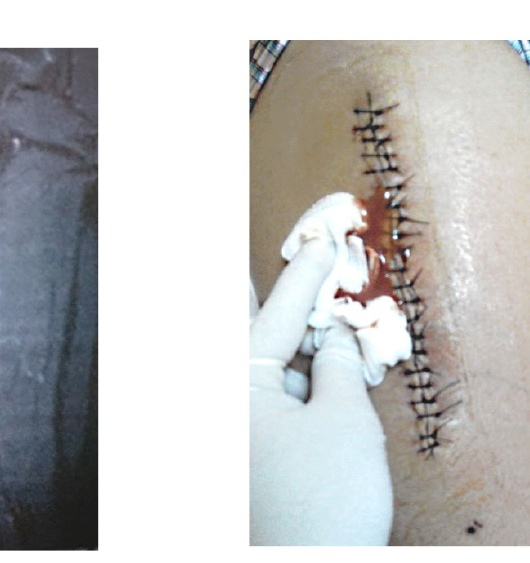
Figure 5. Secondary healing following negative pressure wound therapy